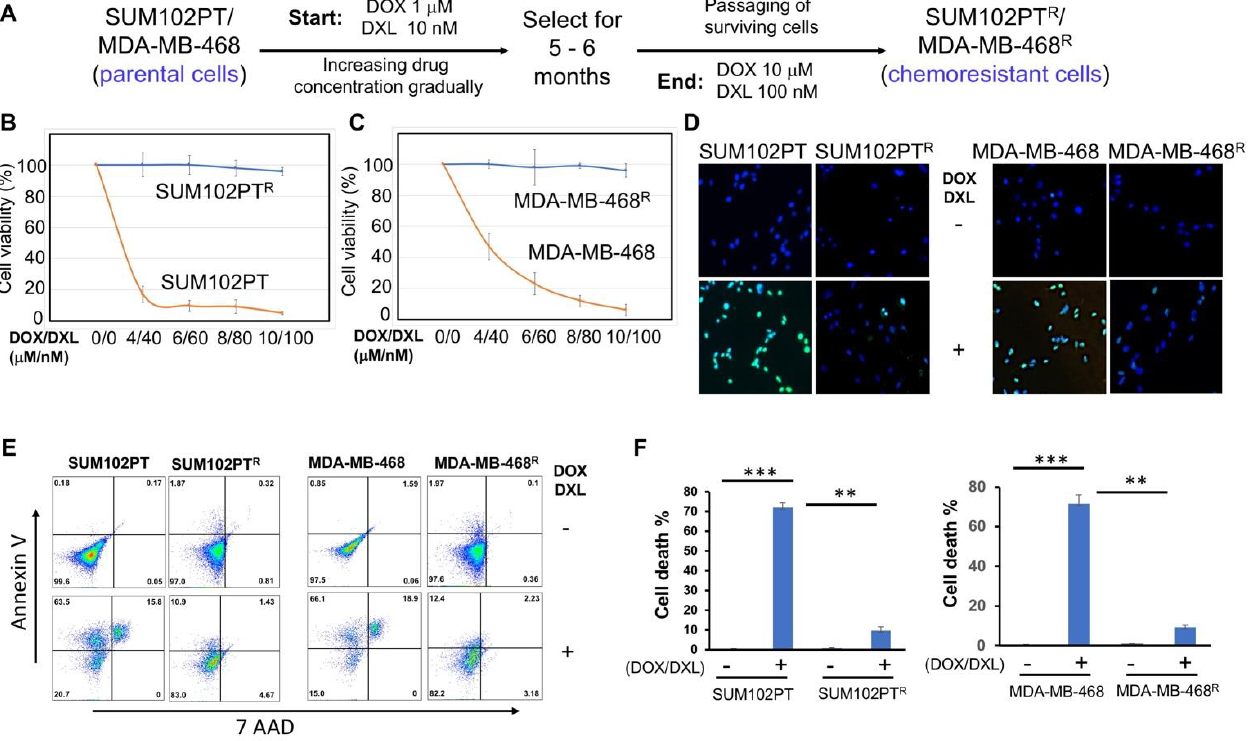
Figure 2. Schematic diagram of the procedure for generating chemoresistant TNBC cells. ( A ) SUM102PT and MDA-MB-468 cells were exposed to DOX/DXL. The concentration of drugs was gradually in- creased (DOX/DXL:1 µ M/10 nM, 2 µ M/20 nM, 4 µ M/40 nM, 6 µ M/60 nM, 8 µ M/80 nM, 10 µ M/ chemoresistance between SUM102PT and SUM102PT R cells, and ( C ) between MDA-MB-468 and MDA- MB-468 R cells. The data presented represent the mean values ± SD ( n = 3). ( D ) TUNEL apoptosis assays comparing the chemoresistance between SUM102PT and SUM102PT R , and between MDA-MB-468 and MDA-MB-468R cells. ( E ) Representative images from flow cytometry analyses to compare the levels